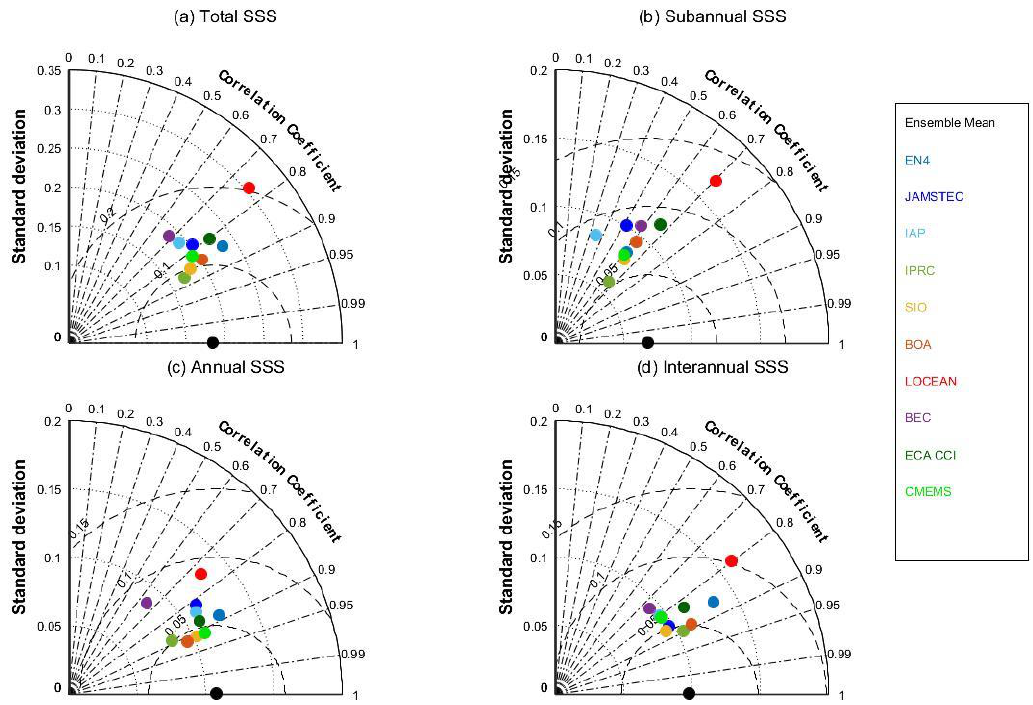
Figure 15. Taylor diagrams comparing ten SSS products on different time scales averaged over the global ocean. The black circle denotes the ensemble mean, dark blue denotes EN4, blue represents JAMSTEC, light blue represents IAP, green represents IPRC, yellow represents SIO, orange represents BOA, red represents LOCEAN, purple represents BEC, dark green denotes ECA CCI and bright green denotes CMEMS.